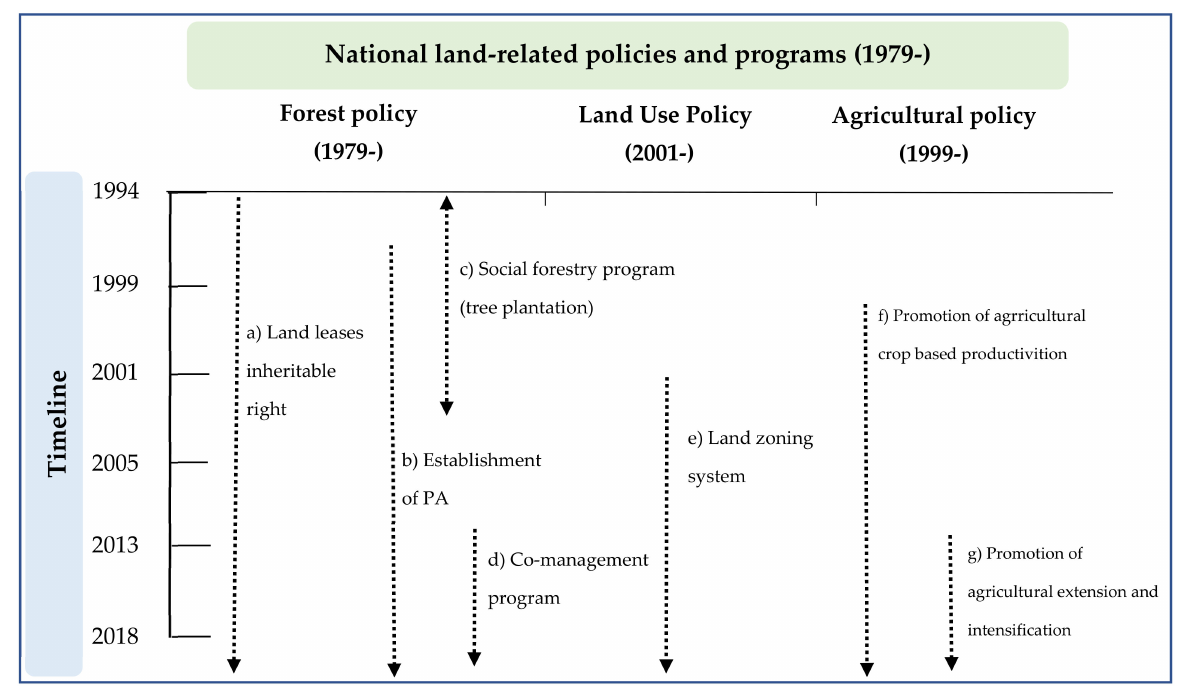
Figure 1. National land-related policies and programs in Bangladesh since 1979. ( a ) Muhammed et al. 2008; Rahman et al. 2018; ( b ) Muhammed et al. 2008; ( c ) Hossain., 2016; ( d ) Chowdhury and Koike., 2010; Mukul et al. 2008; ( e ) Millat-e-Mustafa., 2001; MLNR., 2019; ( f ) Tapa and Rasul., 2006; Hasan et al., 2013; ( g ) Ministry of Agriculture Report.,